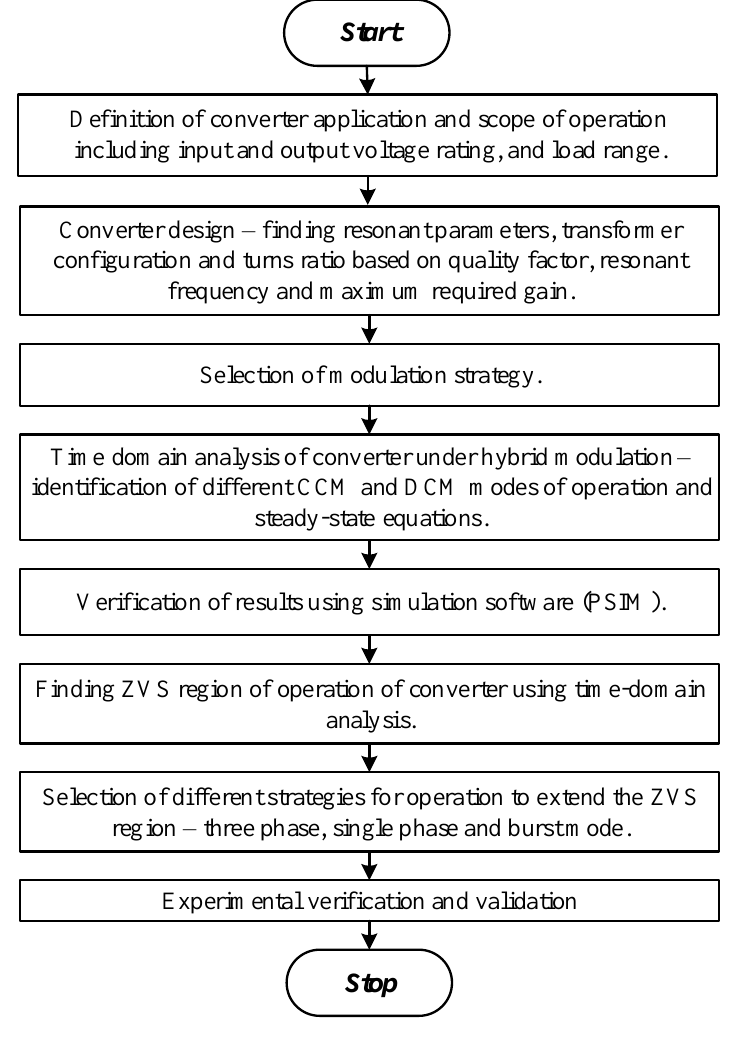
Figure 2. Research flow